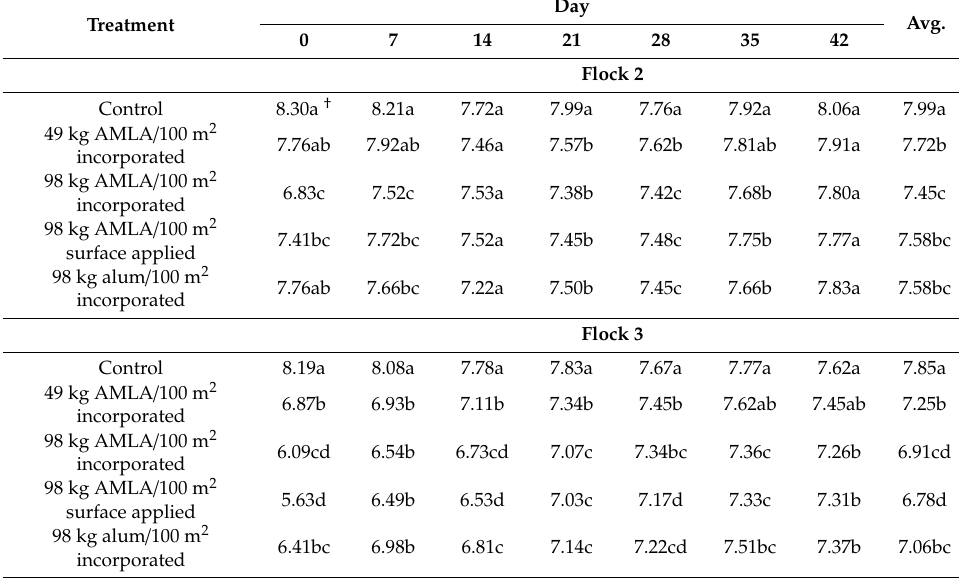
Table 2. Litter pH for flock 2 and 3 by treatment by day.